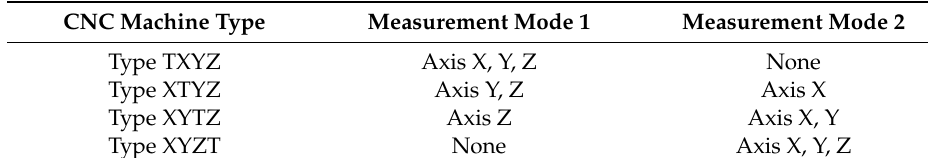
Table 1. Linear axis measurement modes of the different types of machine tools.